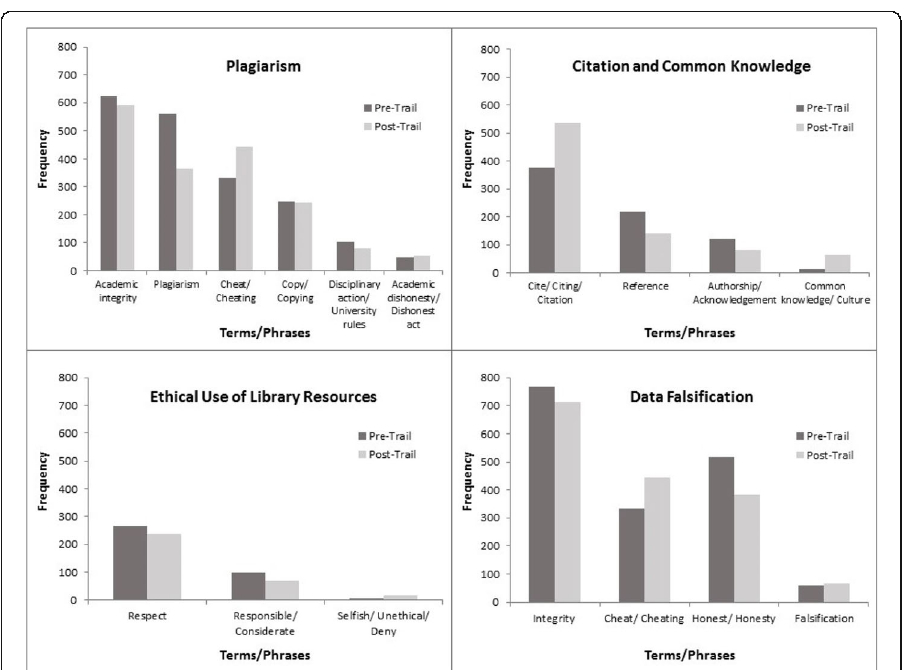
Fig. 3 Comparison of students ’ pre-/post-TIE-General reflections on the four AIE issues (January 2015 — December 2016; n